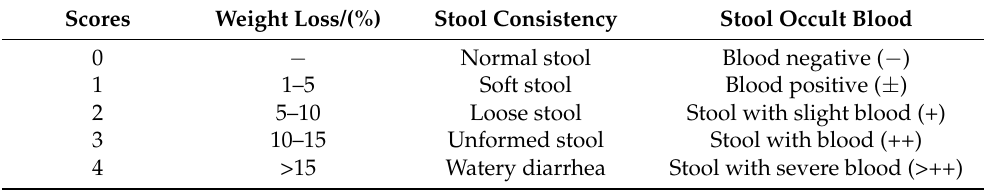
Table 1. DAI score